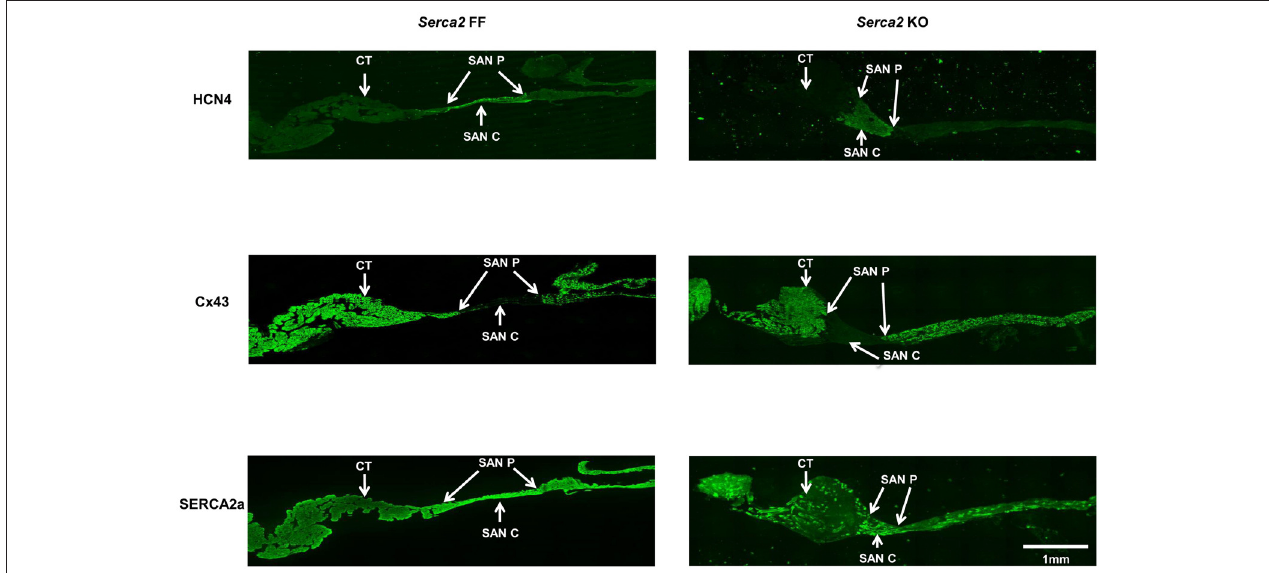
FIGURE 6 | Immunolabelling of HCN4, Cx43, and SERCA2 in right atrial sections from Serca2 FF and Serca2 KO hearts. Top row, right atrial sections from Serca2 FF (left) and Serca2 KO (right) hearts showing HCN4 labeling (green signal) in the sinus node periphery (SAN P) and center (SAN C). Middle row, connexin 43 (Cx43) labeling (green signal) in the right atrium. Bottom row, right atrial sections showing SERCA2a labeling (green signal) throughout the tissue section in Serca2 FF (left) and a mosaic pattern of SERCA2a labeling in Serca2 KO (right). Abbreviations : CT, crista terminalis ; SAN P, sinus node periphery; SAN C, sinus node center.